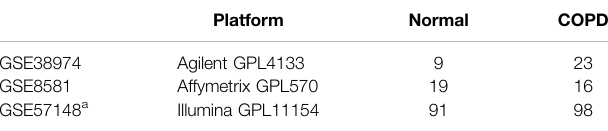
TABLE 1 | Human COPD data used in this study.